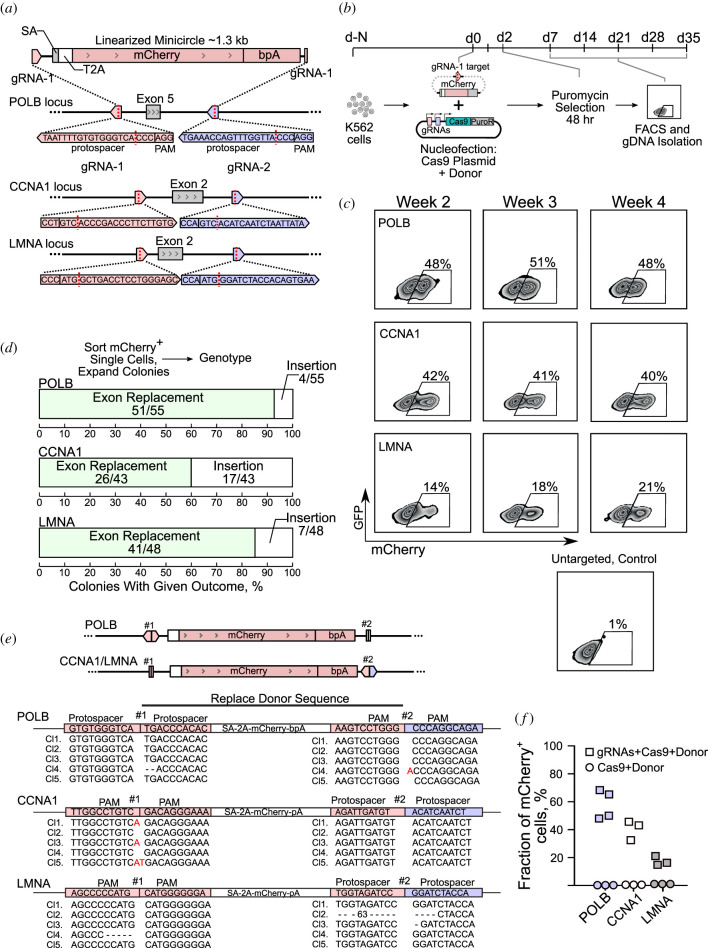
Exon Replace editing in K562 cells. (a) Replacement of POLB Exon 5, CCNA Exon 2 or LMNA Exon 2 with a cherry reporter including a splice acceptor (SA), T2A self-cleaving peptide and a polyadenylation site (bpA). (b) K562 cells cotransfected with Cas9-2A-puro/guides plasmid and mCherry Minicircles were puromycin selected for 48 h and followed by FACS analysis over five weeks. (c) mCherry+ count of transfected cell cultures was measured weekly by FACS. (d) Colonies of mCherry+ single cells were expanded and genotyped to check and quantify replacement of the exon with the donor sequence. (e) Sanger sequencing of amplicons showing InDels at the interface of the integrated donor sequence. (f) Biological replicates of Replace targeting of POLB, CCNA1 and LMNA loci.